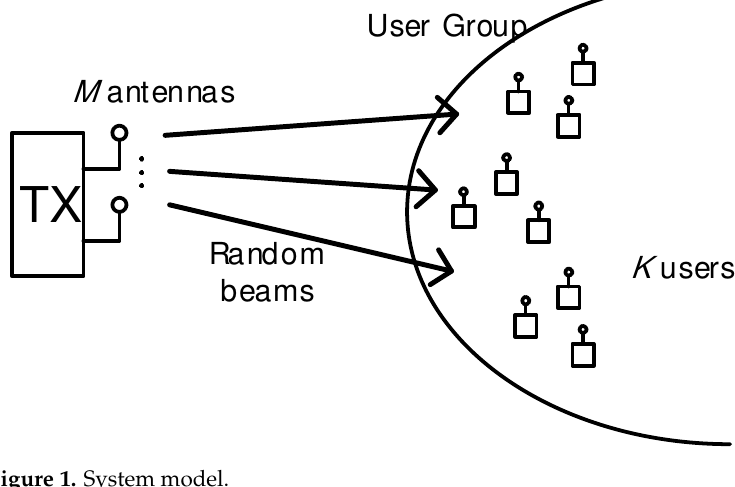
Figure 1. System